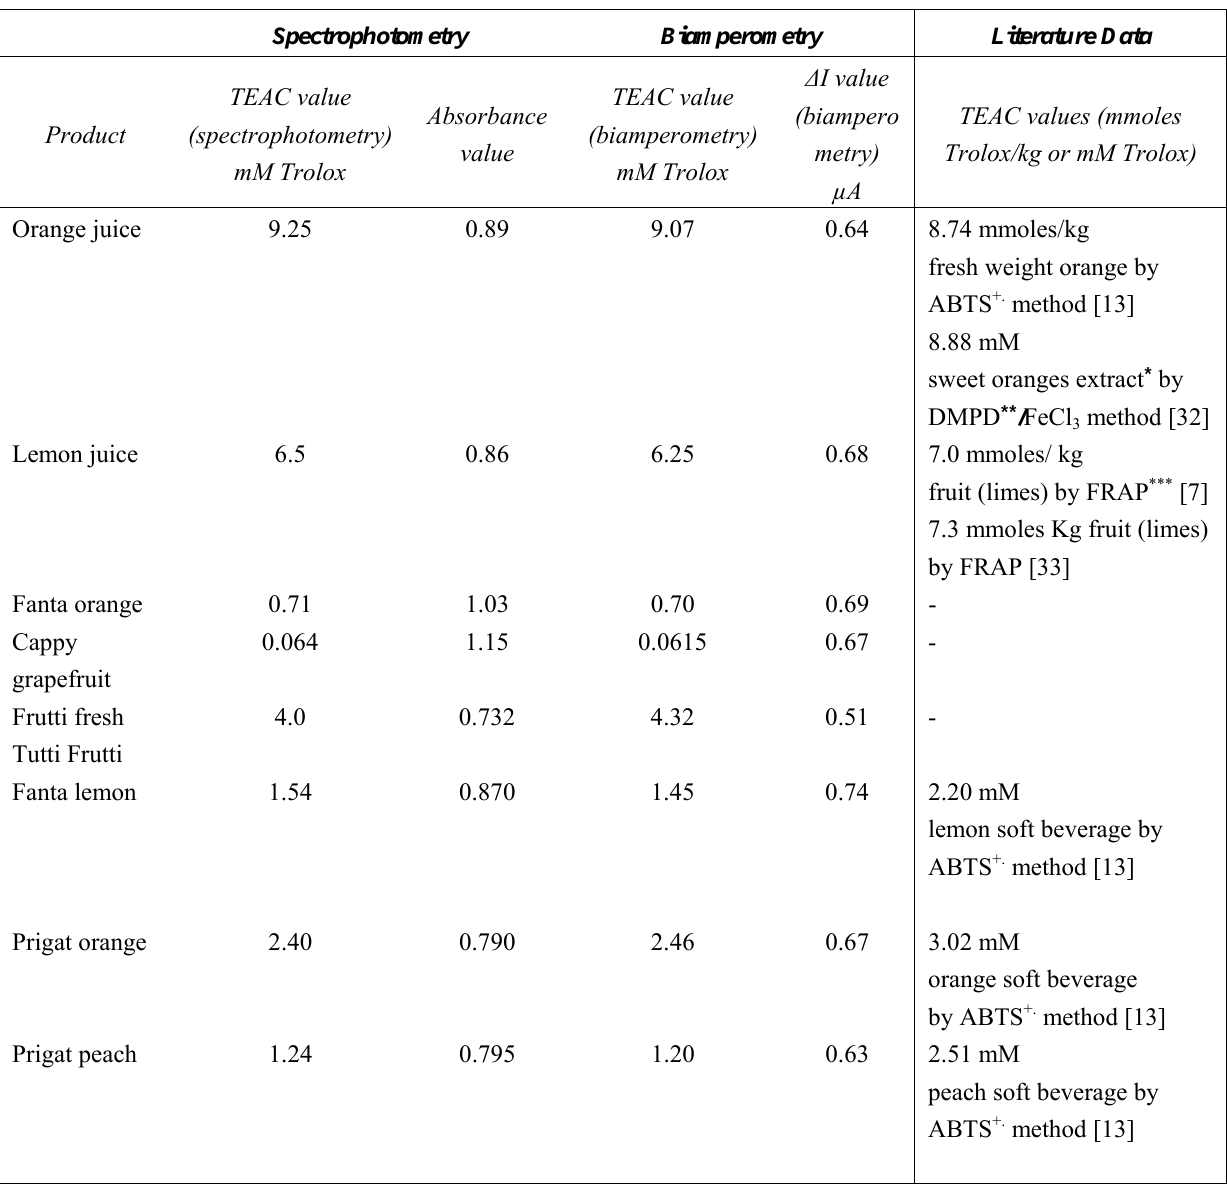
Table 1 . Results, expressed as TEAC obtained for total antioxidant activity determination in fruit juices by spectrophotometry and biamperometry and comparison with literature